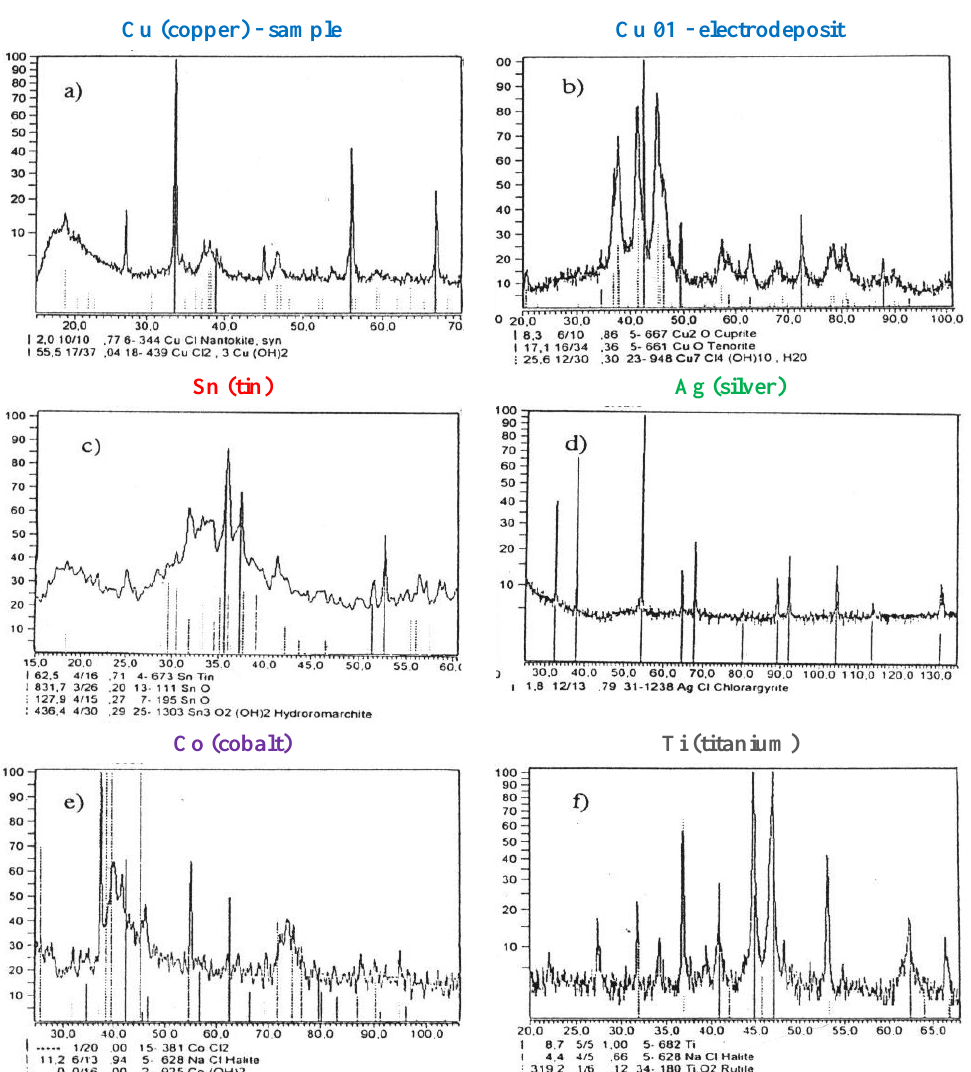
Figure 8. X-ray diffraction patterns of the grinding wheel erosion products: ( a ) Copper—the sample; ( b ) Copper— electrodeposit; ( c ) Tin; ( d ) Silver; ( e ) Cobalt; ( f ) Titanium; Electrolyte solution E3.